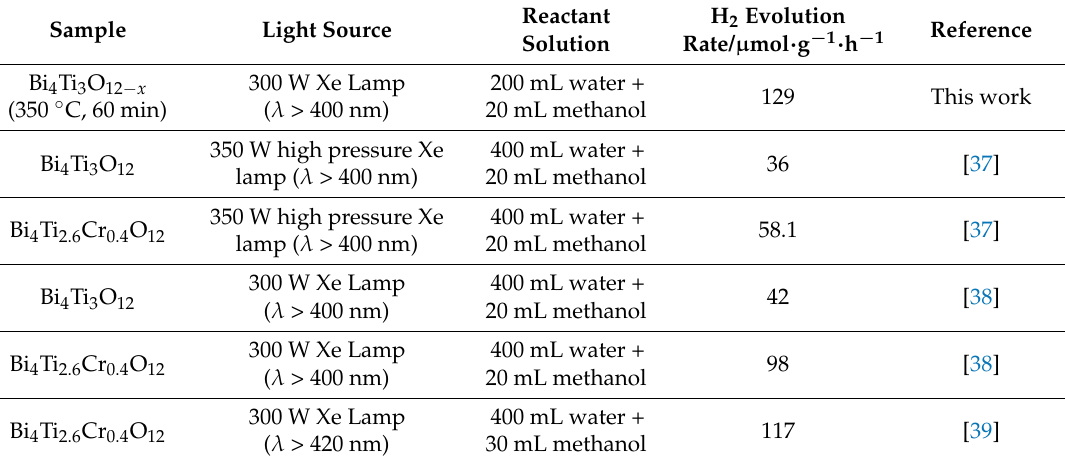
Table 2. Comparison of H 2 evolution rate of Bi 4 Ti 3 O 12 − x (350 ◦ C, 60 min) and other Bi 4 Ti 3 O 12 photocatalysts recently